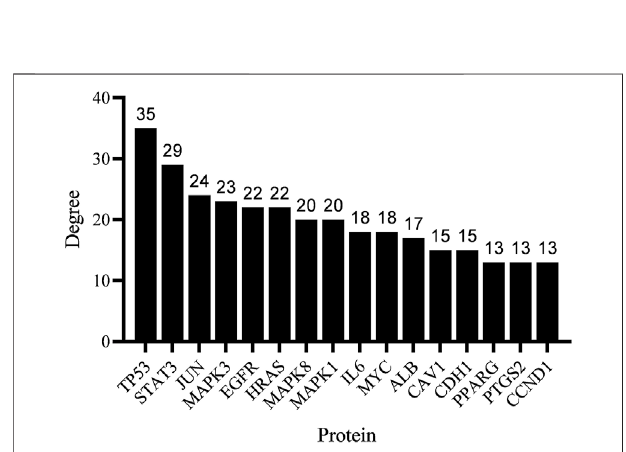
FIGURE 5 | The degree value of the target protein